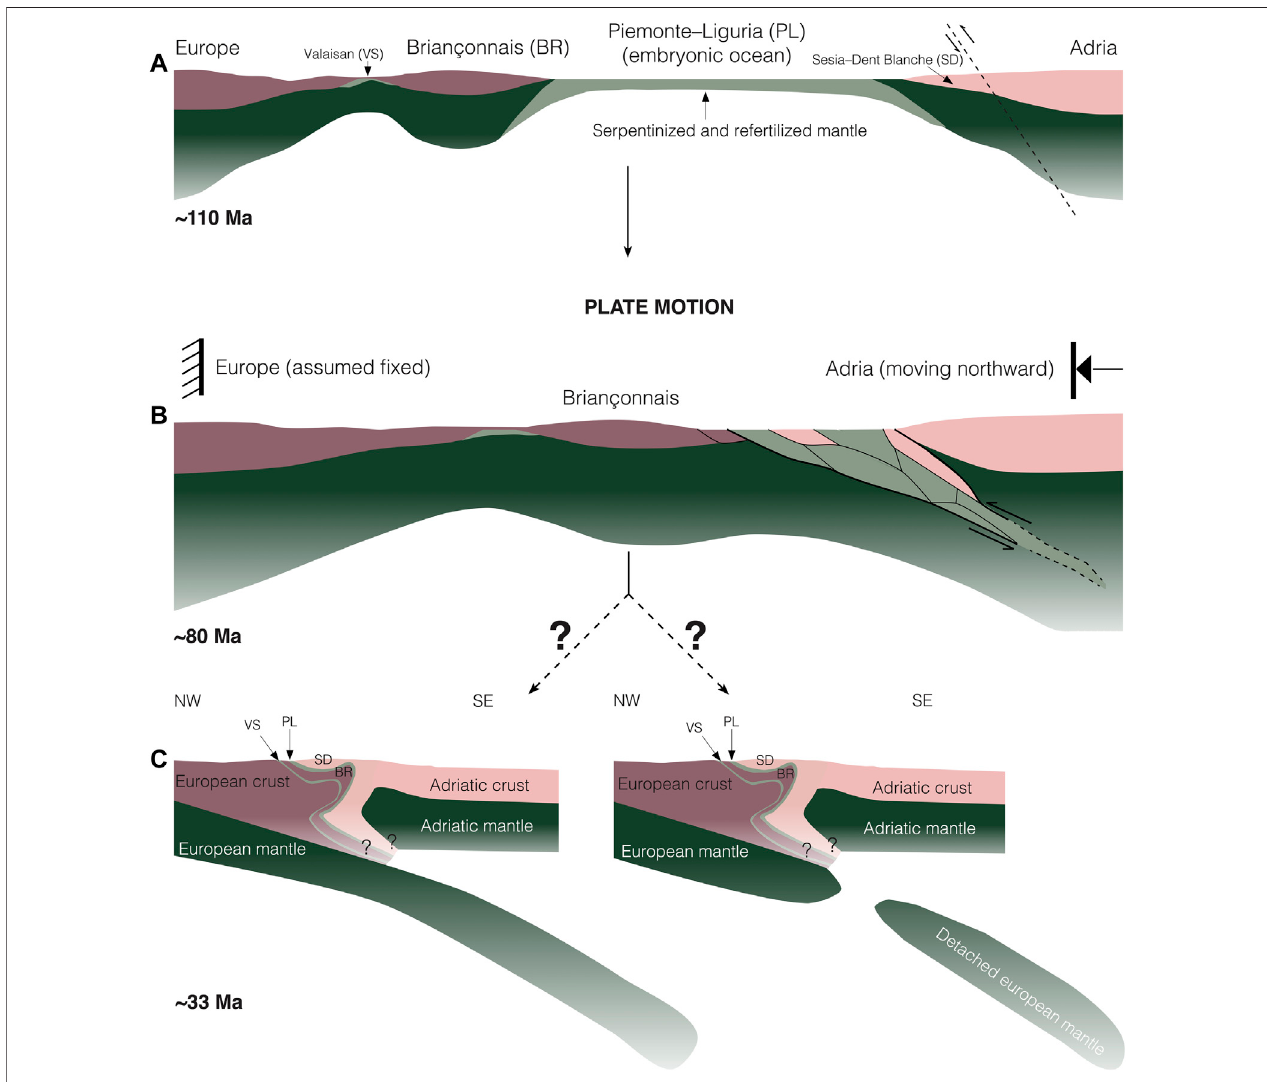
FIGURE 1 | Simpli fi ed conceptual geodynamic sketch of the Alpine orogeny. (A) Passive margin geometry and embryonic oceans after the rifting stage. (B) Horizontally-forced SZI at the Adriatic passive margin and subduction of the Sesia – Dent Blanche unit. (C) Possible scenarios for the collisional stage of the Alpine orogenywithacontinuouslysubductingslab(left)ordetached slab(right).Geologicalunits aresimpli fi edand takenfrom Schmid etal.(2017) andMcCarthyetal.(2020).